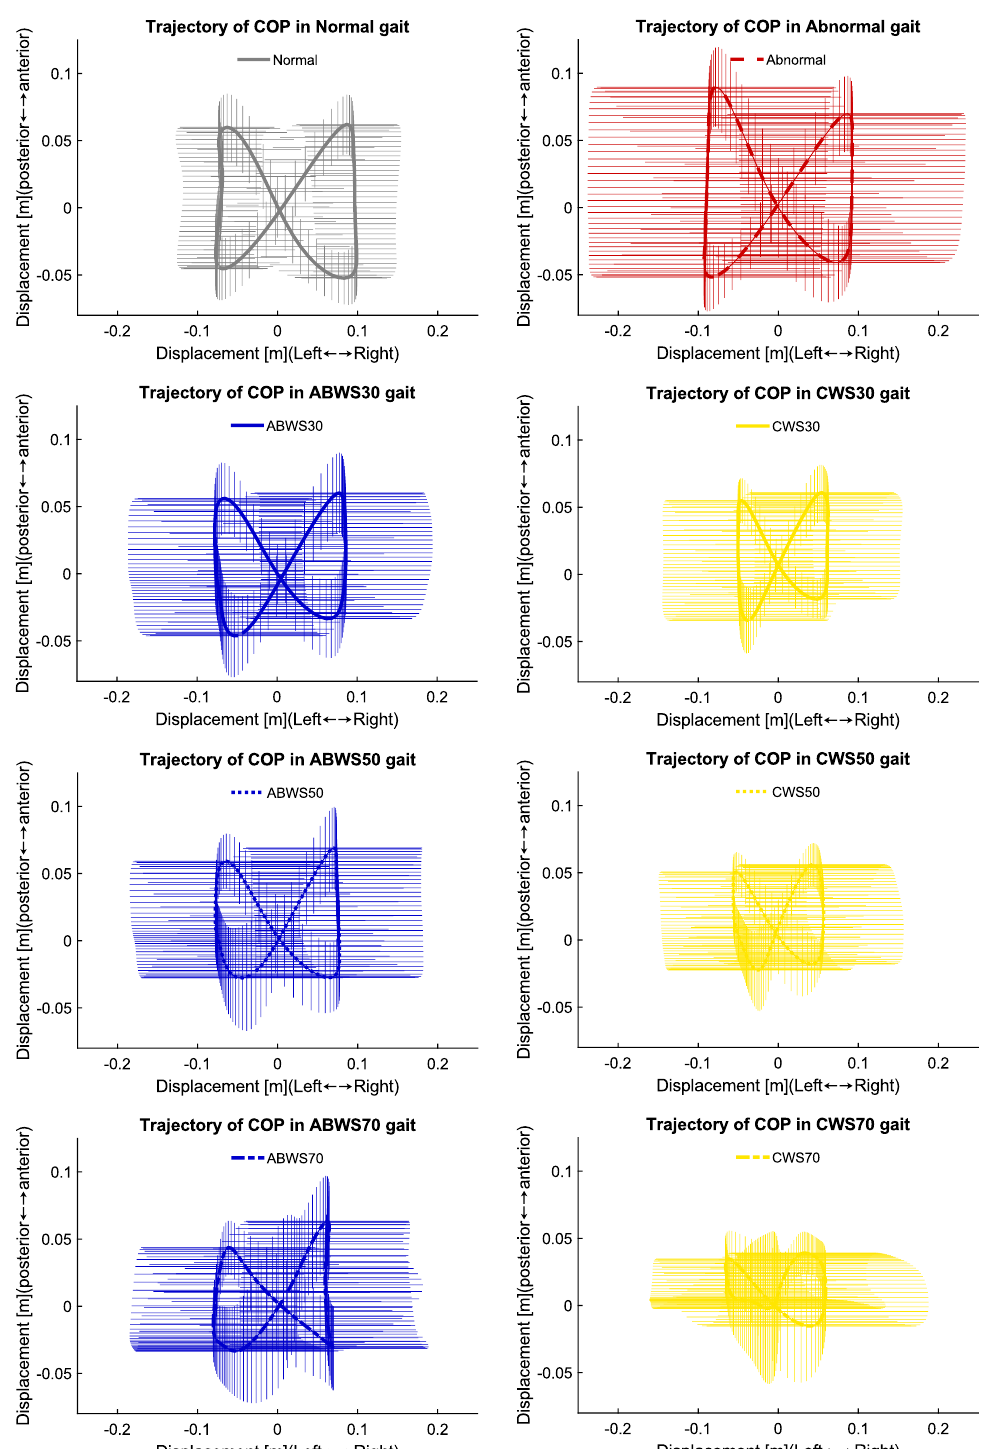
Figure 6. The mean and the variance of COP trajectory of all subjects while walking under different